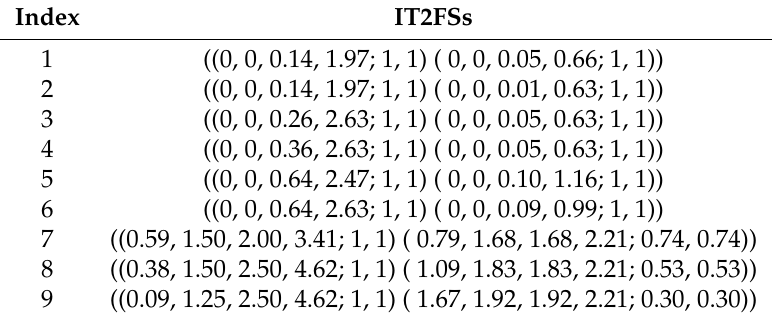
Table 3. The arc lengths of the fuzzy graph, represented as interval type-2 fuzzy sets